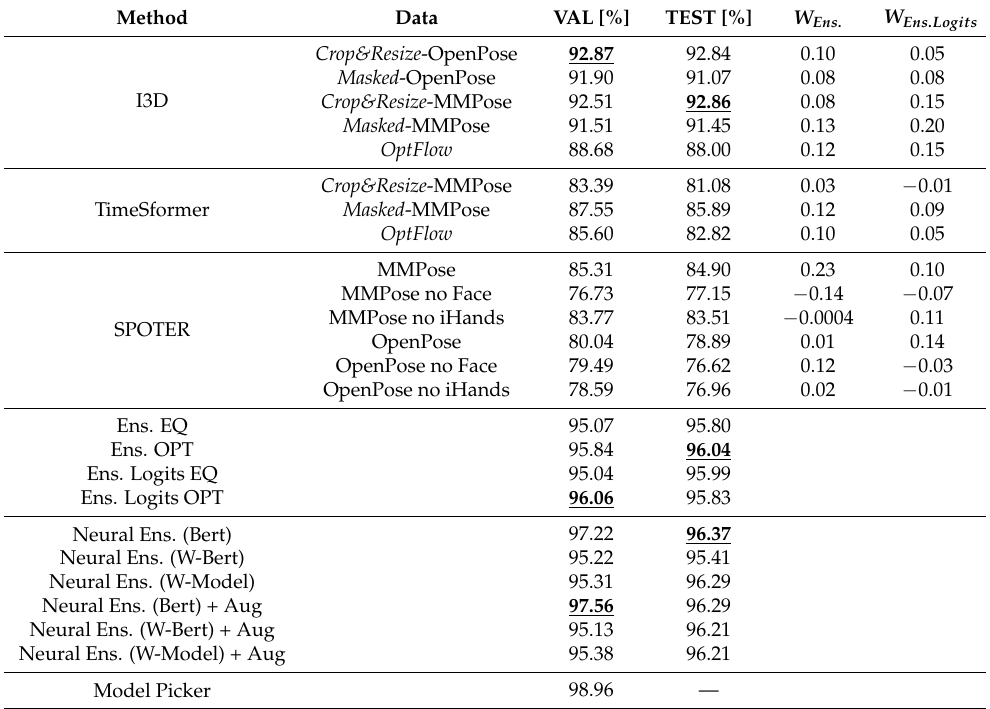
Table 3. AUTSL results. Model Picker = percentage of samples that were recognized correctly by at least one model. Ens. EQ = equally weighted ensemble, Ens. OPT = ensemble with optimized weights, Logits = using logits outputs instead of softmax, Neural Ens. = neural ensembler, Bert = bert-like transformer, W-Bert = bert-like weighter, W-Model = model weighter. W Ens . and W Ens . Logits = weights of individual models in the CMA-ES